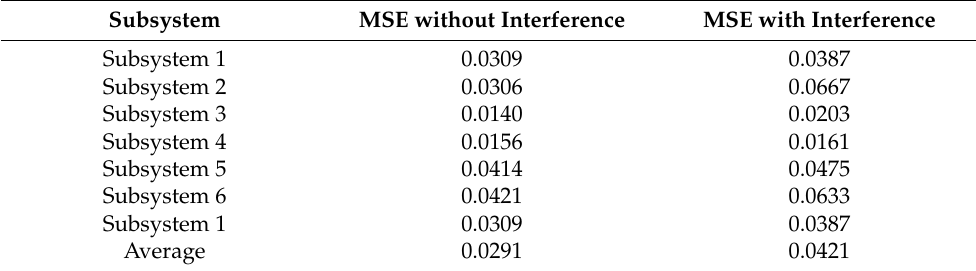
Table 1. Mean squared error (MSE) of the actual concentration and set concentration when dis- turbance occurs.